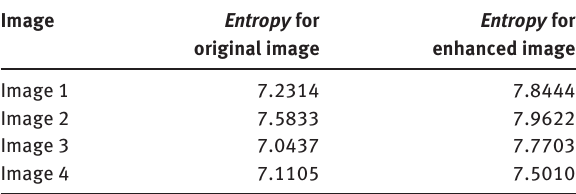
Table 6. Results for